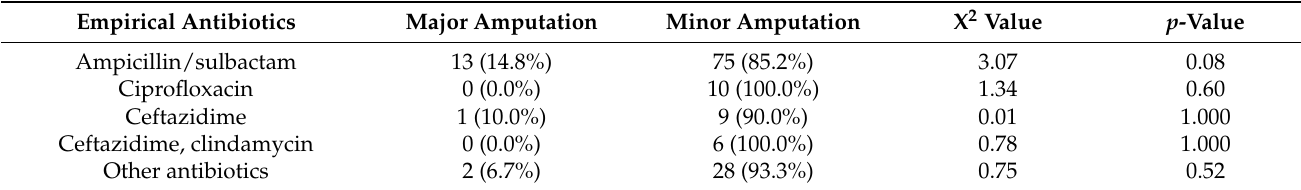
Table 9. Association between amputations and empirical antibiotics